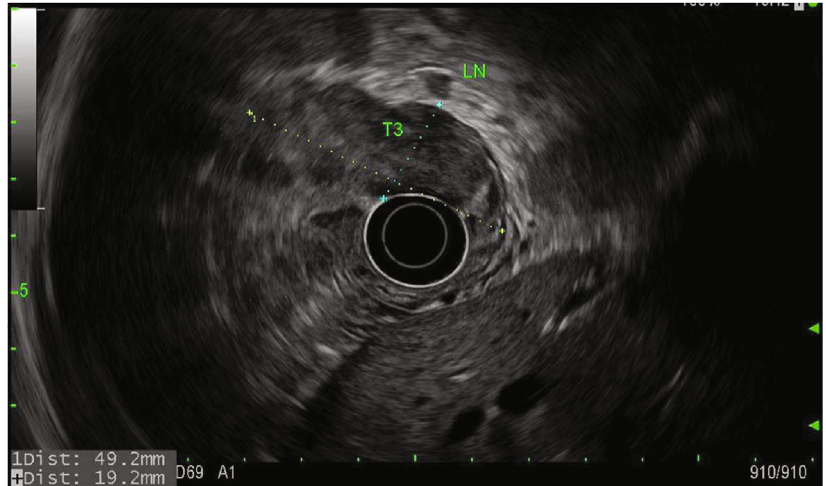
Figure 2: EUS — a hypoechoic mass involving two-thirds of the gastric circumference measured 4 : 8 × 1 : 9 cm, with serosal invasion and two malignant-appearing lymph nodes (one shown in fi eld-of-view) in the paracardial region (level 16), T3N1MX by endosonographic criteria.